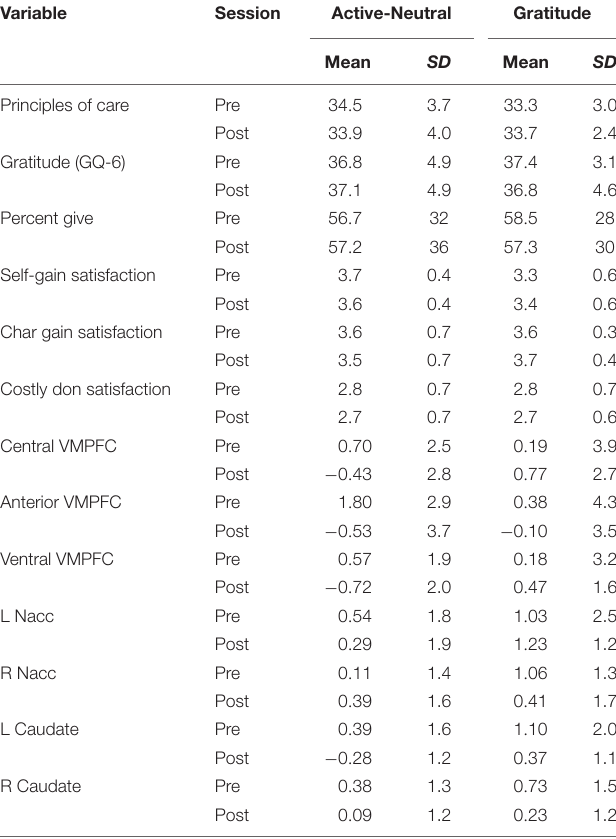
TABLE 5 | Pre and post-test measures in the self report, behavioral, and neural domains. Variable